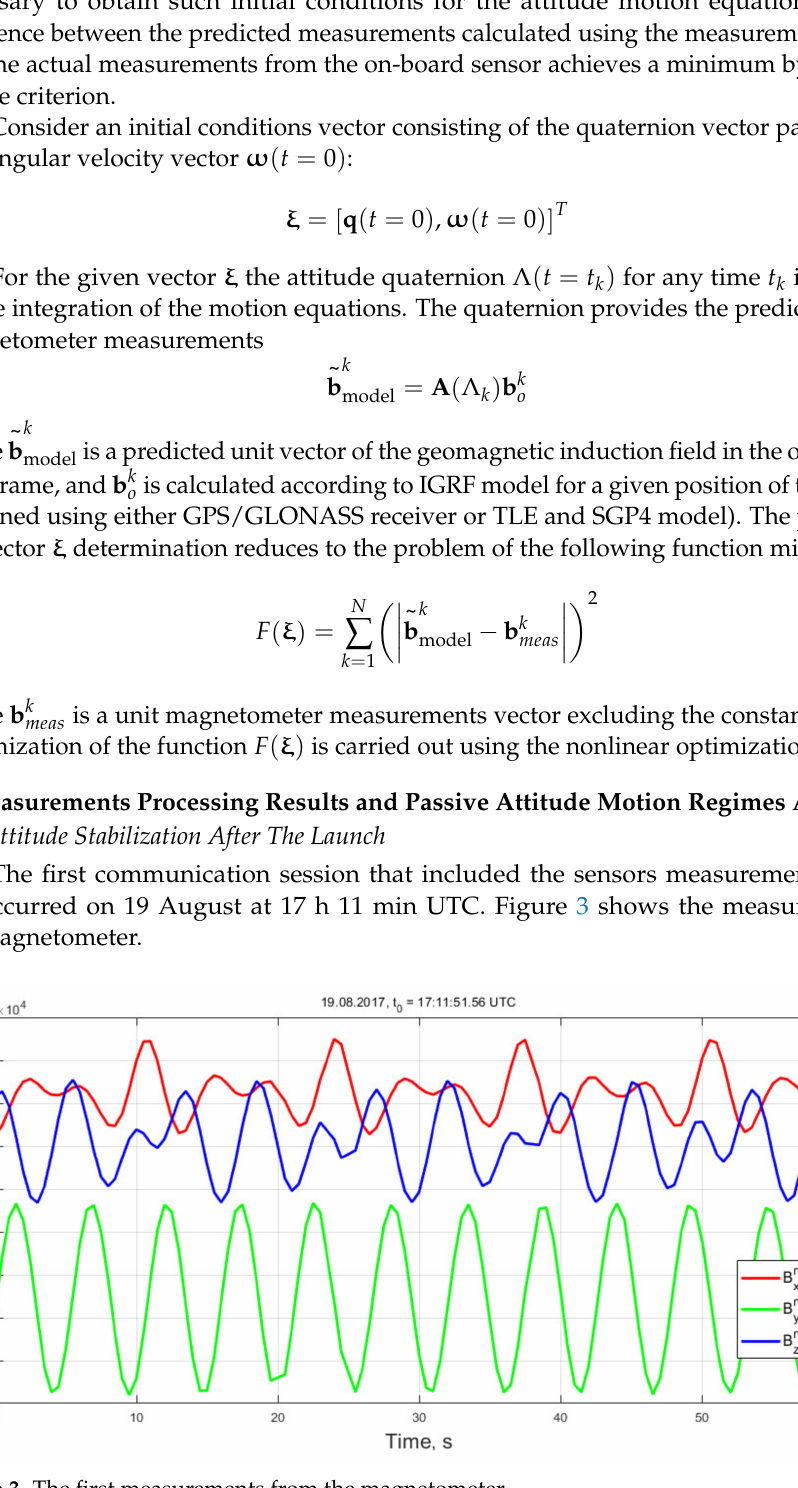
Figure 3. The first measurements from the